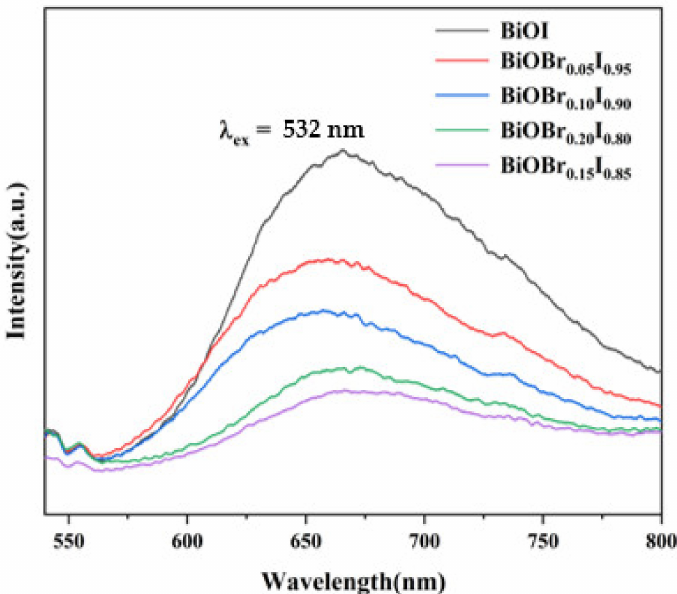
Figure 6. PL spectra of BiOBr X I 1 − X composites and pure BiOI. The light absorption capacity of the catalyst had an important effect on the photocat- alytic degradation of organic pollutants, so the absorption characteristics were studied by UV-vis DRS. It can be observed in Figure 7a that both BiOI and BiOBr 0.15 I 0.85 had ex- cellent visible light absorption. The band gap energy of as-prepared samples can also be calculated by fitting a plot of ( α h ν ) 1/2 versus h ν in Figure 7b. The Eg of BiOBr, BiOI, and BiOBr 0.15 I 0.85 were 2.86 eV,1.87 eV, and 1.89 eV, respectively, which indicates that Br doping clearly changes the absorption properties and widens the bandgap of the solid solution.